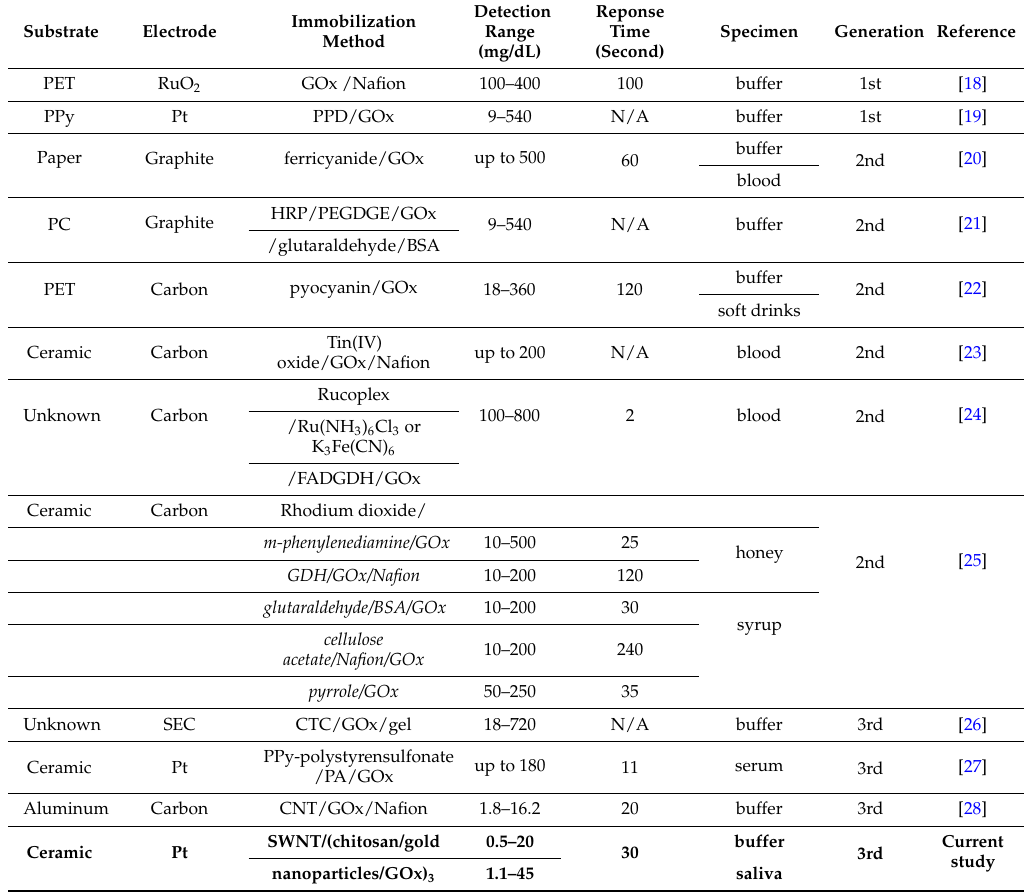
Abbreviations of Table 1: N/A, not applicable because glucose is measured from continuous flow; SWNT, single-walled carbon nanotubes; PET, polyethylene terephthalate; PC, polycarbonate; PPy, polypyrrole;